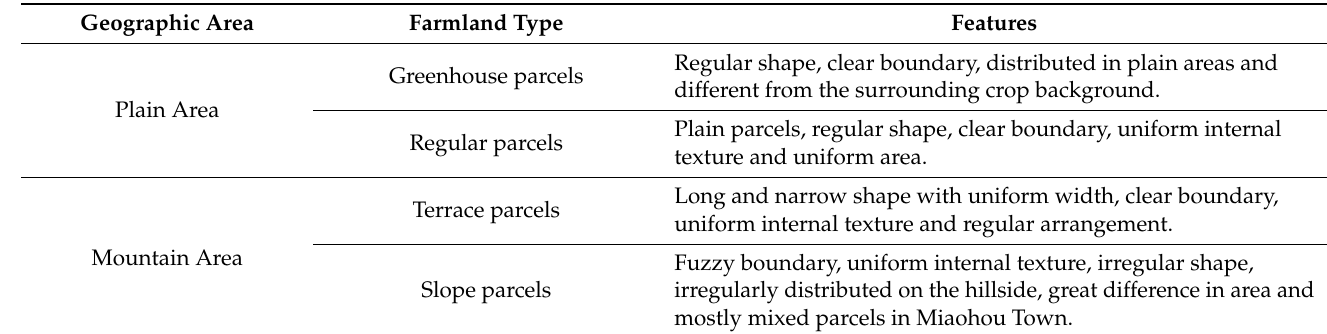
Table 1. Parcel type table. Geographic Area Farmland Type Features